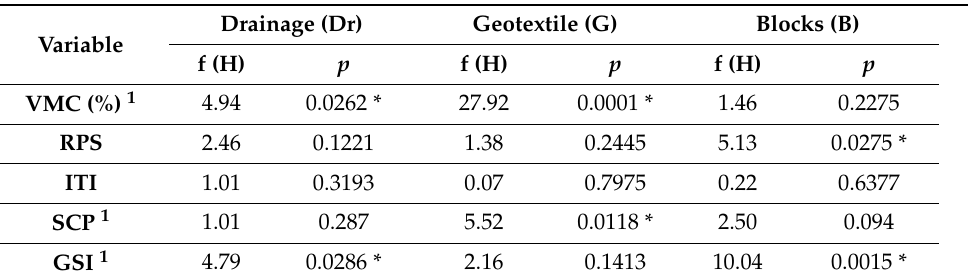
Table 2. Statistics for the VMC (%), RPS, ITI, SCP, and GSI and GSS (f and p -value), to three